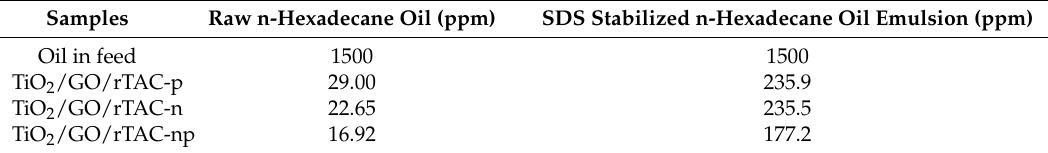
Table 1. Residual TOC rates of raw n- hexadecane oil and SDS-stabilized n-hexadecane oil emulsion in permeate for different